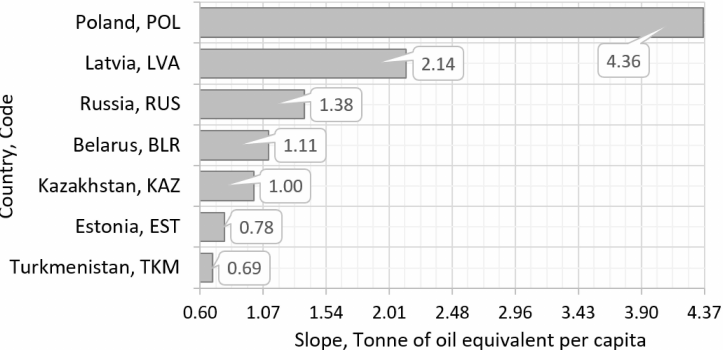
Figure 3. Distribution of countries by the slope parameter. Note: developed by the authors.